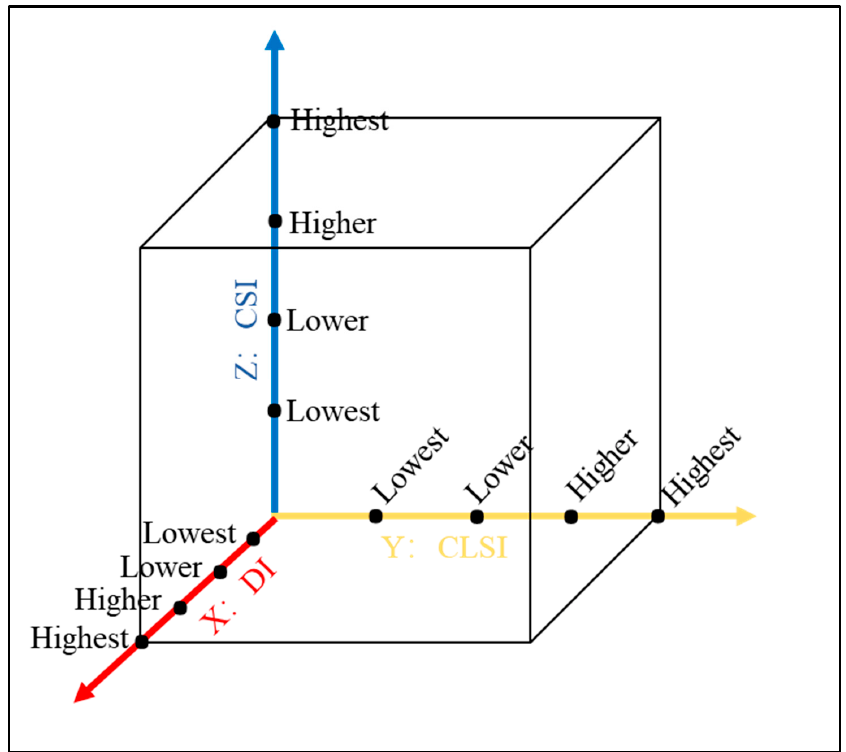
Figure 4. The diagram for cultivated land zoning identi fi cation three-dimensional model.